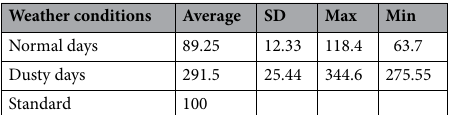
Table 1. The concentration of PM 10 (μg/m 3 ) before and after the dust